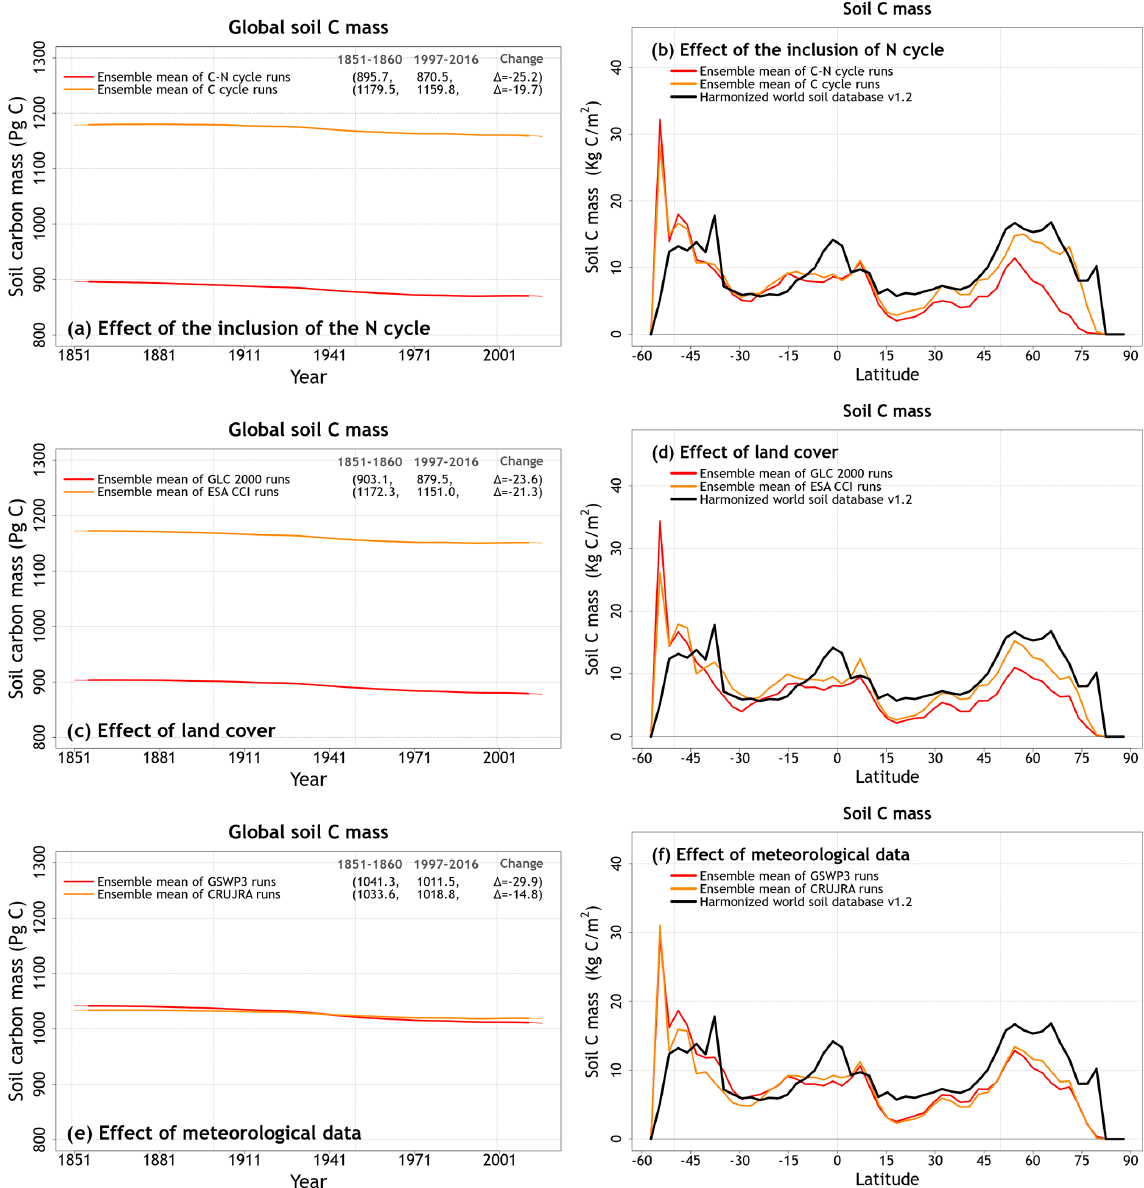
Figure 6. Time series of annual global soil carbon mass (over all land area excluding Greenland and Antarctica) (a, c, e) and zonally averaged values of soil carbon mass over land (b, d, f) averaged, for the period 1997–2016, over the four ensemble members that are driven with and without an interactive N cycle (a, b) , that are driven with the GLC-2000- and ESA-CCI-based land cover representations (c, d) , and that are driven with GSWP3 and CRU-JRA meteorological data (e, f) . The thin lines for the time series show the individual years, and the thick lines show their 11-year moving average. Model values averaged over the pre-industrial (1851–1860) and present-day (1997–2016) time periods, and their difference, are also shown in (a, c, e)